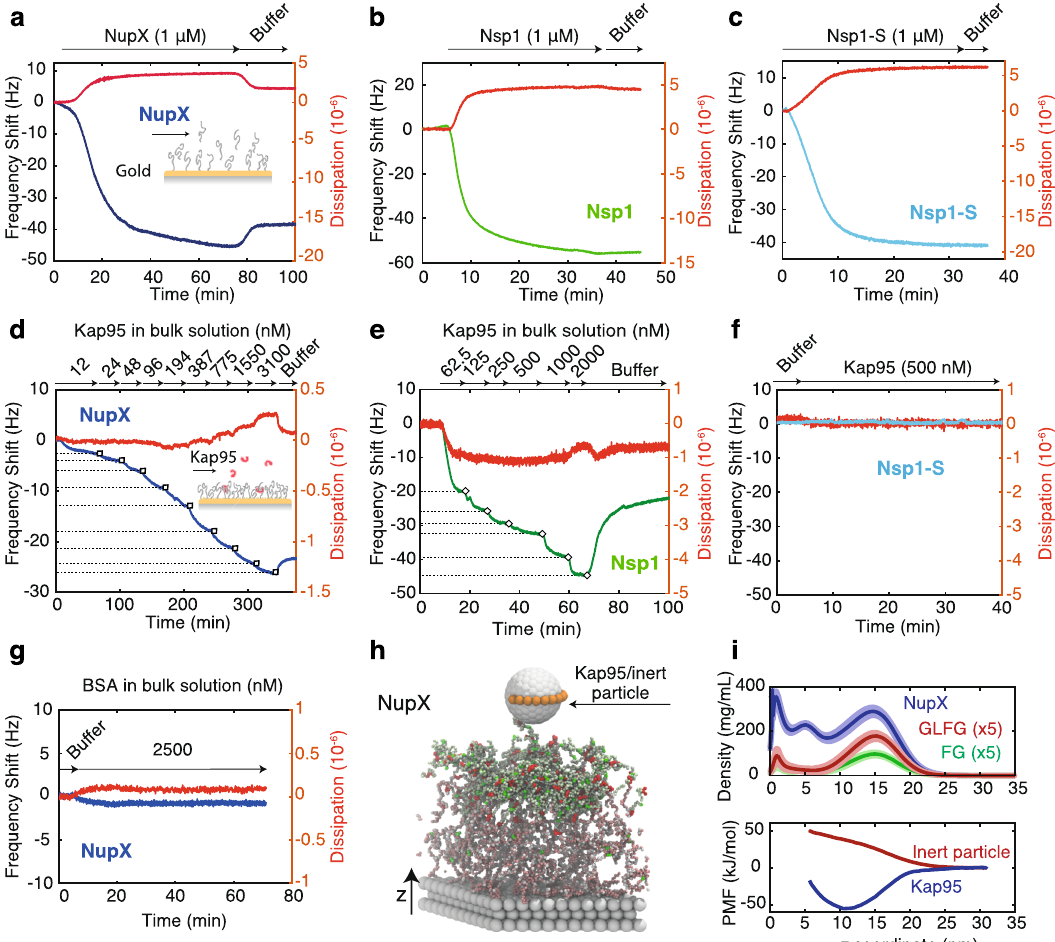
Fig. 2 Binding af fi nity of Kap95 to NupX, Nsp1 and Nsp1-S brushes, using QCM-D and MD simulations. a – c Change in frequency shift upon coating of gold surface with NupX (dark blue), Nsp1 (green) and Nsp1-S (light blue) proteins, respectively, at 1 μ M protein concentration. Red curves indicate the corresponding shift in dissipation. d – f Change in frequency shift upon titration of Kap95 (with concentration in the range ~10 – 3000 nM) on NupX (dark blue), Nsp1 (green) and Nsp1-S (light blue) coated surfaces. Numbers indicate the concentration in nM of Kap95 for each titration step. Large changes in frequency shift are observed for NupX and Nsp1, whereas no detectable shift is measured for Nsp1-S. Red curves indicate the corresponding shift in dissipation. g Frequency (dark blue) and dissipation (red) shift upon adsorption of 2.5 μ M BSA onto the NupX-coated sensor. h Side-view snapshot of the umbrella sampling simulation setup for a NupX brush with 4.0 nm grafting distance, where a model Kap95 particle (8.5 nm diameter grey sphere with binding sites depicted in brown) or inert particle (7.5 nm diameter, not shown) is restrained along different z -coordinates. Scaffold beads are shown in grey, NupX proteins follow the same colour scheme as presented in Fig. 1b. i Top panel: time and laterally averaged protein density distributions for the NupX brushes (blue) and for the FG-motifs (green) and GLFG-motifs (red) present inside the NupX brushes with a grafting distance of 4.0 nm. The density pro fi les of the GLFG- and FG-motifs within the NupX brush are multiplied by 5 for clarity. Dark central lines and light shades indicate the mean and standard deviation in density pro fi les, respectively. These measures were obtained by averaging over the density pro fi les of trajectory windows 50 ns in length ( N = 60). High-density regions (up to almost 400 mg/mL) form near the attachment sites ( z = 0 – 2 nm) and near the free surface of the brush layer (at z ~ 15 nm). FG- and GLFG-motifs predominantly localize near the free surface of the brush. Bottom: free-energy pro fi les (PMF curves) of the centre of mass of the 8.5 nm sized model Kap95 (blue) and inert particle (red) along the z -coordinate, where z = 0 coincides with the substrate. The difference in sign between the PMF curves of both particles indicates a strong preferential adsorption of the model Kap95 to NupX brushes and a repulsive interaction with the inert